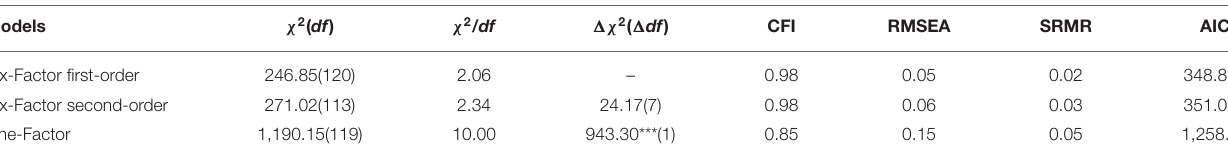
TABLE 3 | Summary of model